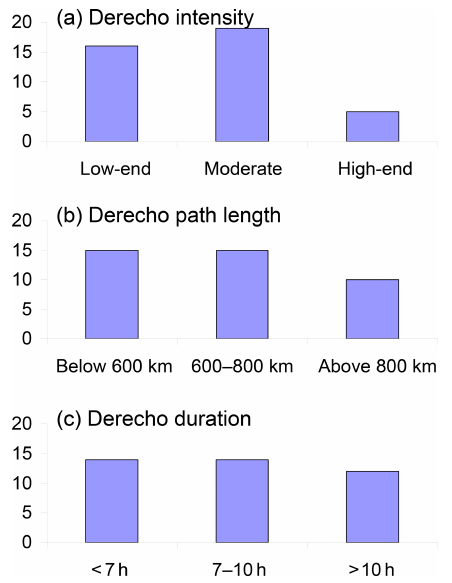
Figure 2. Characteristics of derechos (1997–2014): (a) intensity, (b) path length, and (c) duration.